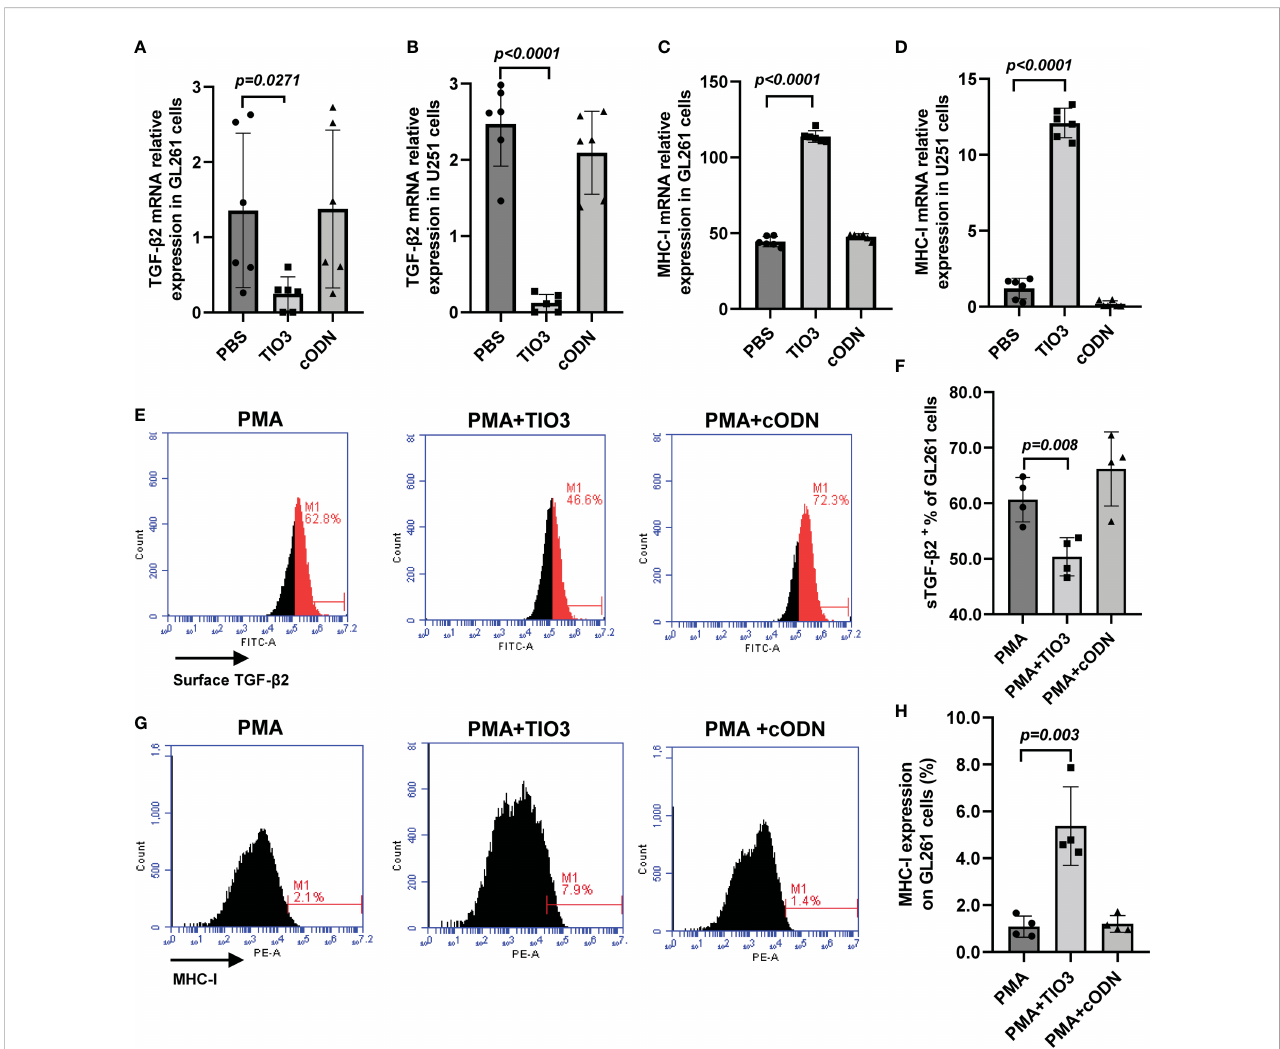
FIGURE 1 Effect of TIO3 on the expression of TGF- b 2 and MHC-I in cultured GL261 cells or U-251 cells. GL261 or U-251 cells were cultured with TCL, TCL+TIO3 (10 m g/mL) or TCL+cODN (control ODN, 10 m g/mL) for 24 h, respectively, and the mRNA expression of TGF- b 2 (A, B) and MHC I (C, D) were measured by qRT-PCR. In addition, GL261 cells were cultured with PMA (100 m g/mL), PMA+TIO3 or PMA+cODN for 48 h, and the protein expression of TGF- b 2 (E, F) and MHC I (G, H) were detected by fl ow